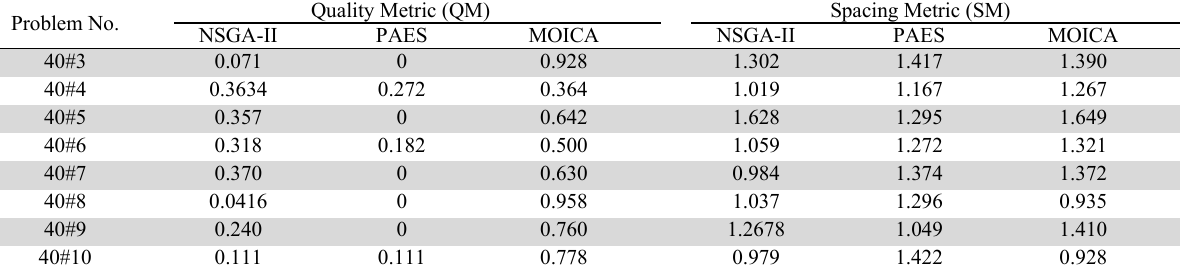
As we can observe from the results of Table 2, the proposed multi-objective ICA (MOICA) performs better than alternative methods; namely NSGA-II and PAES in terms of QM and SM. The results of the survey for problems with size of 40 and distribution channels between 3 to 10 Problem